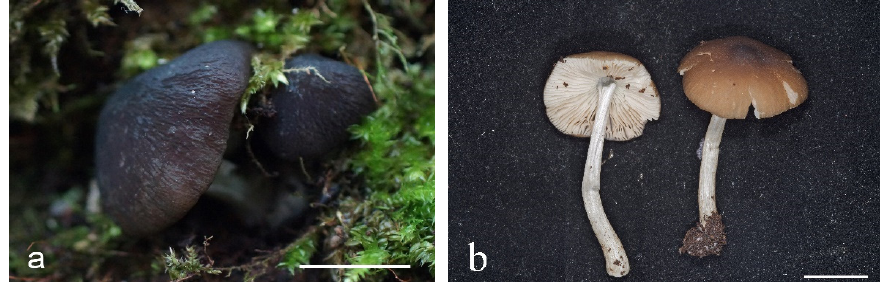
Figure 10. Pluteus assimilatus basidioma in situ: ( a ) LE 313452 (holotype); ( b ) TUF118809 (photo: Vello Liiv). Scale bar 10 mm.